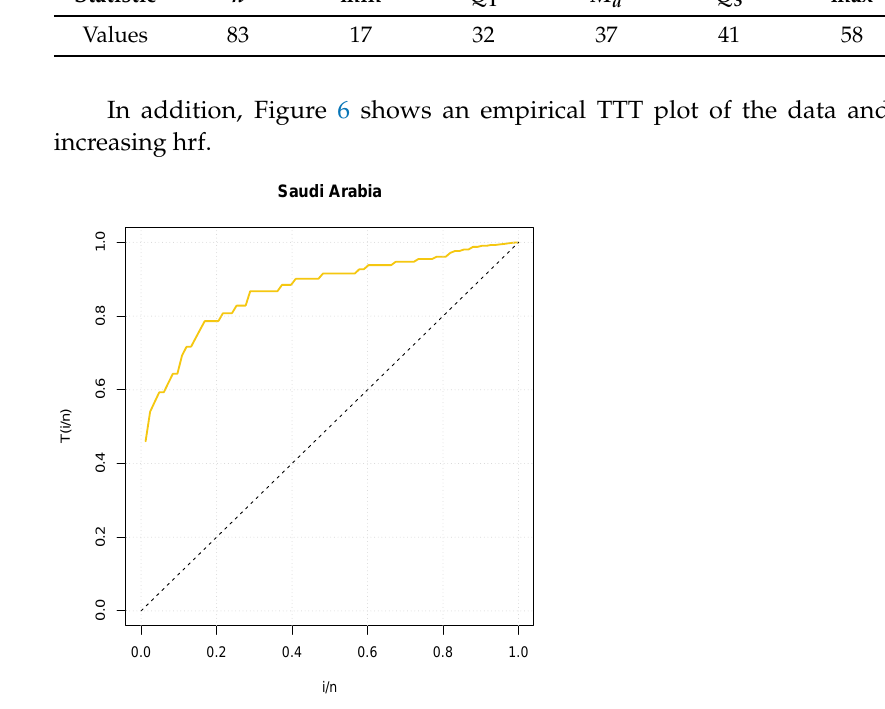
Figure 6. Total Time on Test (TTT) plot for the COVID-19 data set of Saudi